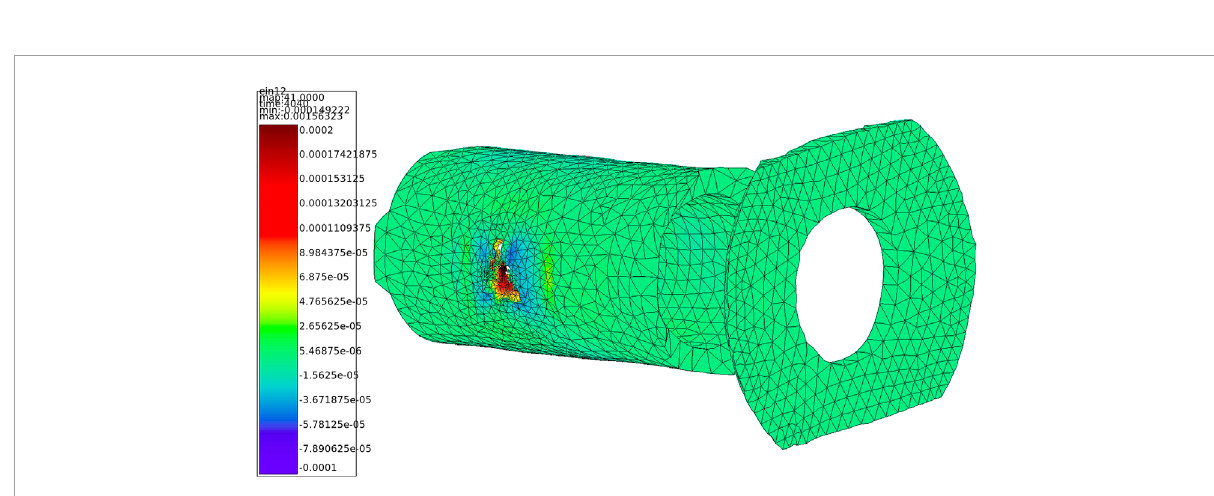
FIGURE 13 Shear strain forecast by the finite element model, in Ω R , at the maximum mechanical loading of the specimen.